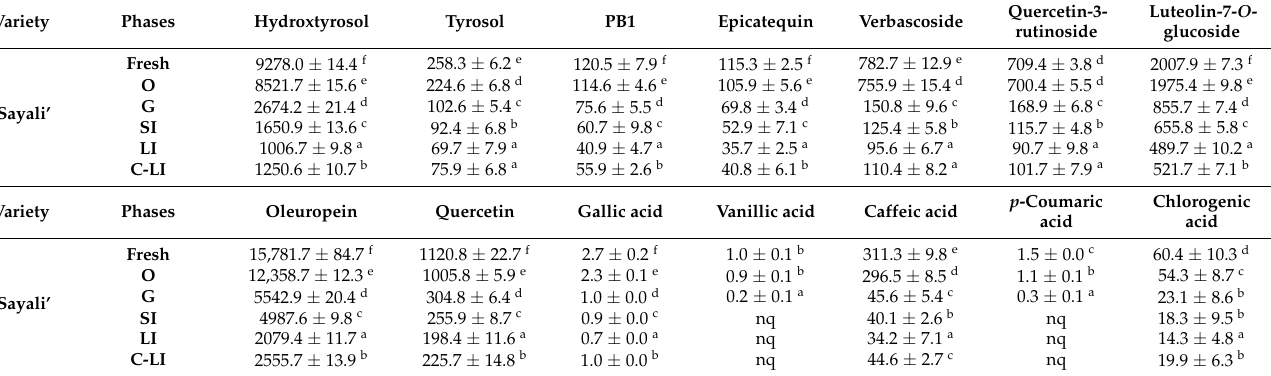
Table 2. Polyphenols concentration of aqueous OLE (mg 100 g −1 ) after in vitro gastrointestinal di- gestion.